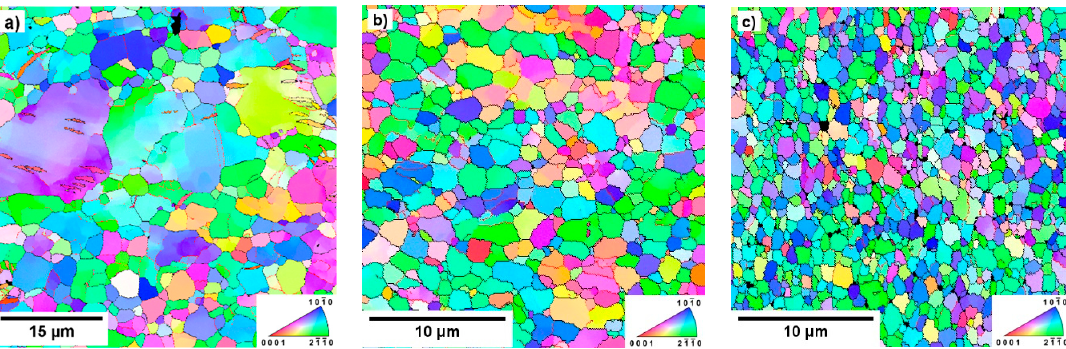
Figure 4. EBSD orientation maps of ( a ) 1P sample, ( b ) 4P sample, and ( c ) 8P sample (cross-section).